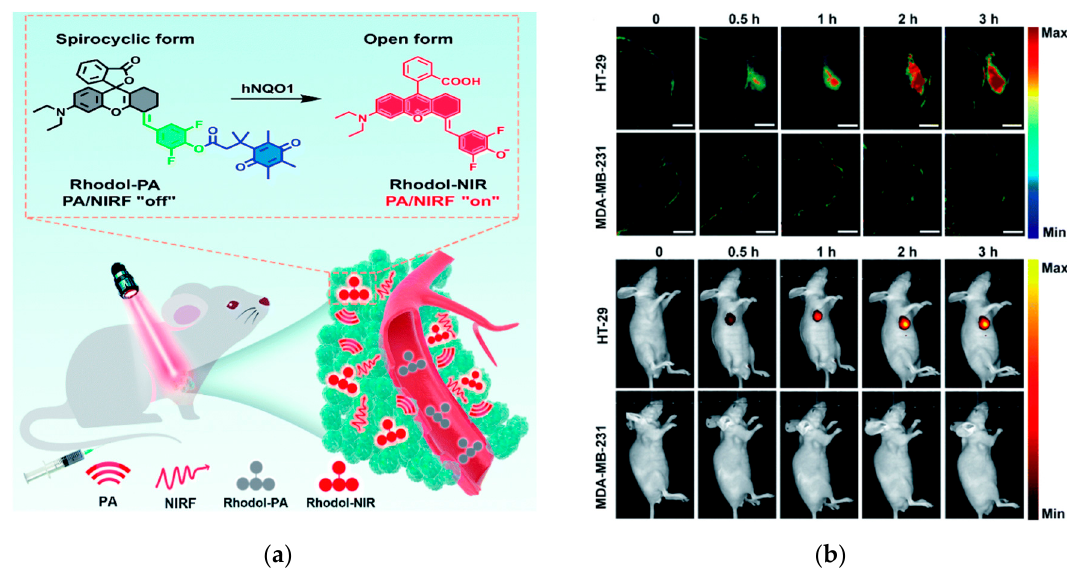
Figure 7. Cancer targeting photoacoustic probe: ( a ) Illustration of the activation mechanism of Rhodol-PA for PA/NIRF imaging; ( b ) Representative photoacoustic ( top ) and fluorescence ( bottom ) images of HT-29 and MDA-MB-231 tumor-bearing living mice at different time points upon intratumoral injection of Rhodol-PA . Adapted with permission from [130]—Published by The Royal Society of Chemistry. Scale bars = 2 mm.